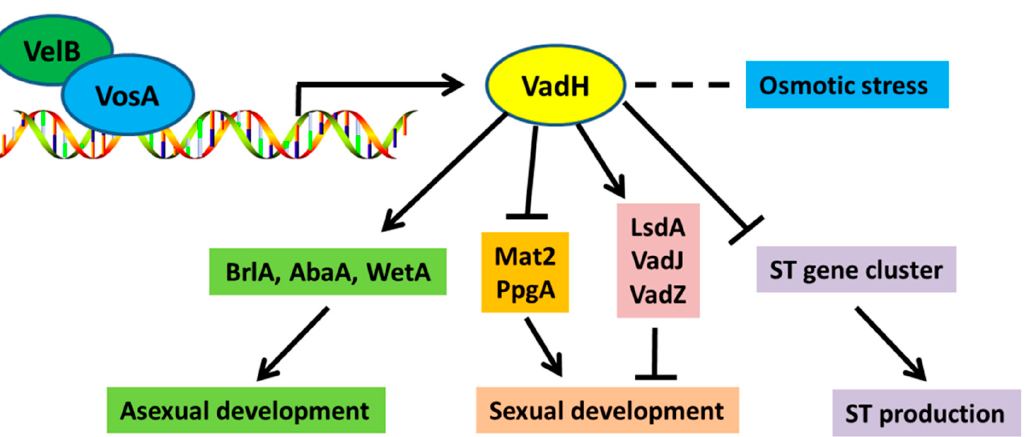
Figure 9. A genetic model of VadH regulating asexual/sexual development and secondary metab- olism of A. nidulans